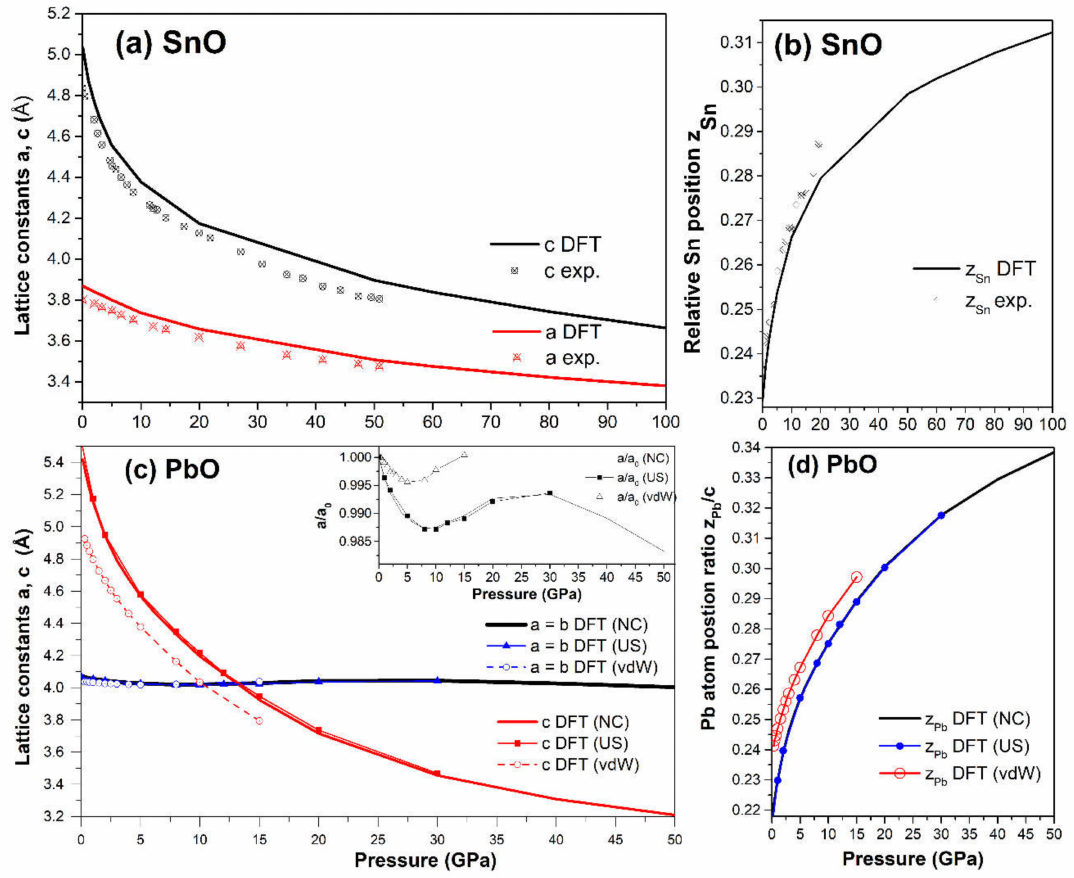
Figure 3. Calculated tetragonal SnO/PbO structural parameters: ( a ) Lattice parameters a and c vs. pressure of SnO compared with experimental measurements [15]; ( b ) Lattice parameters a and c vs. pressure of PbO. The calculation is validated with ultrasoft pseudopotential and vdW hybrid functionals vdw-ob-ft86 [30]. Inset: Enlarged view of the variation of parameter a in PbO; ( c ) Relative Sn atomic position z Sn vs. pressure compared to experimental measurements [12]; ( d ) Relative Pb atomic position z Pb vs.